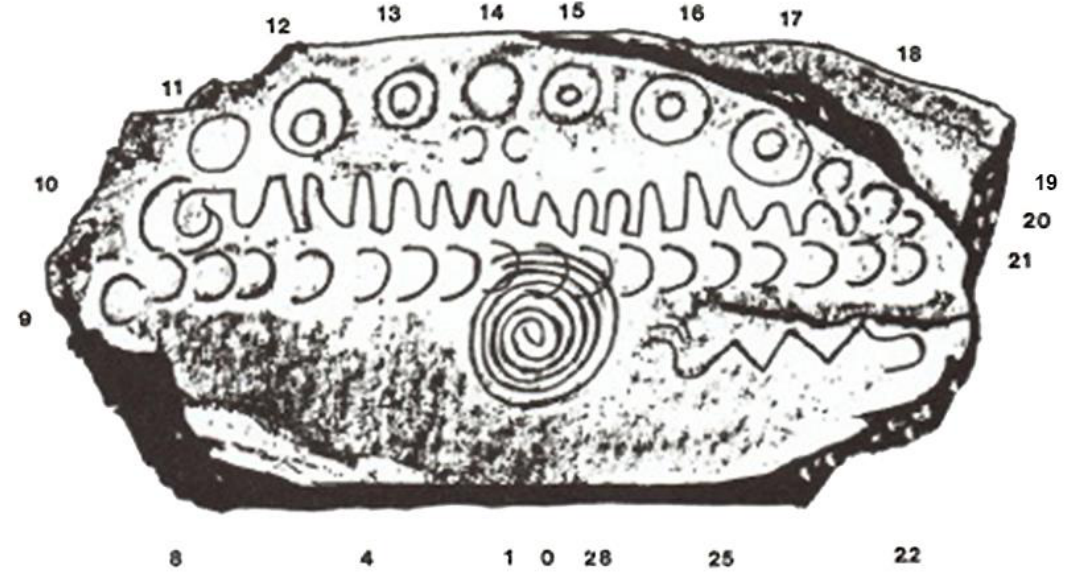
Figure 3. Calendar stone K52 at Knowth (figure from Meaden 1991: